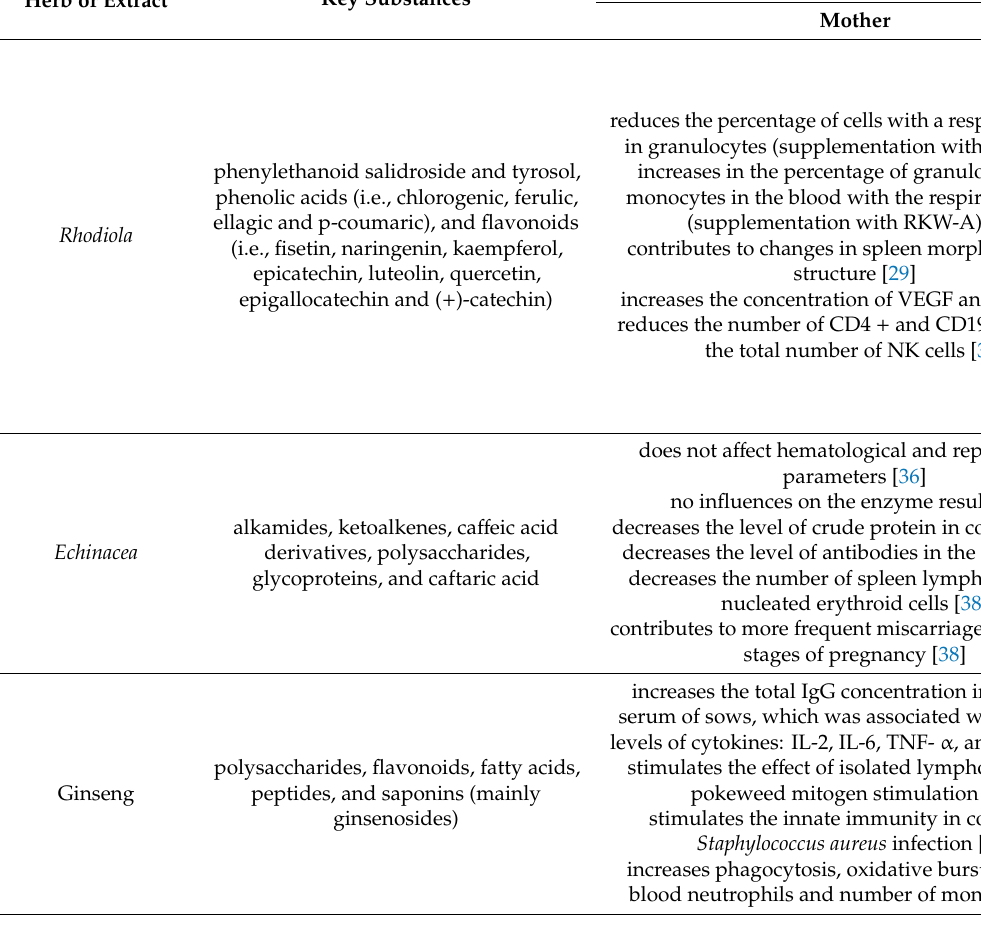
Table 1. Summarized e ff ects of Rhodiola , Echinacea , Ginseng, and Camellia, or its extracts, supplemented in pregnancy and / or lactation on mothers and o ff spring health. Herb or